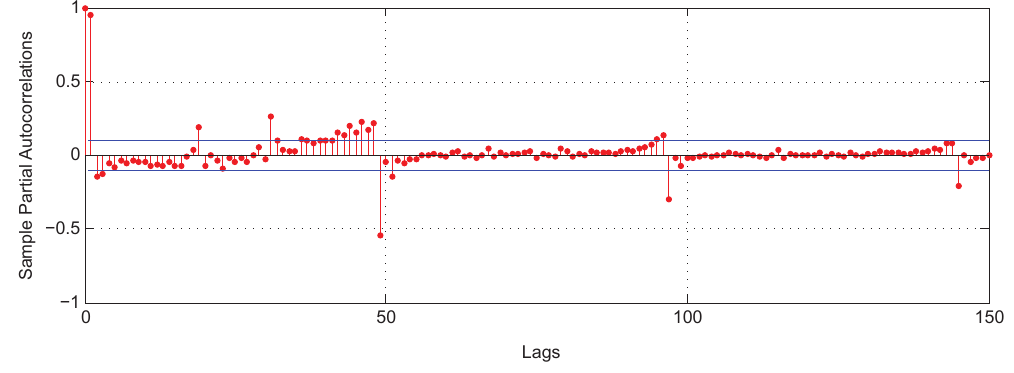
Figure 5. The partial autocorrelation function (PACF) of the 30 min experiment with 150 time